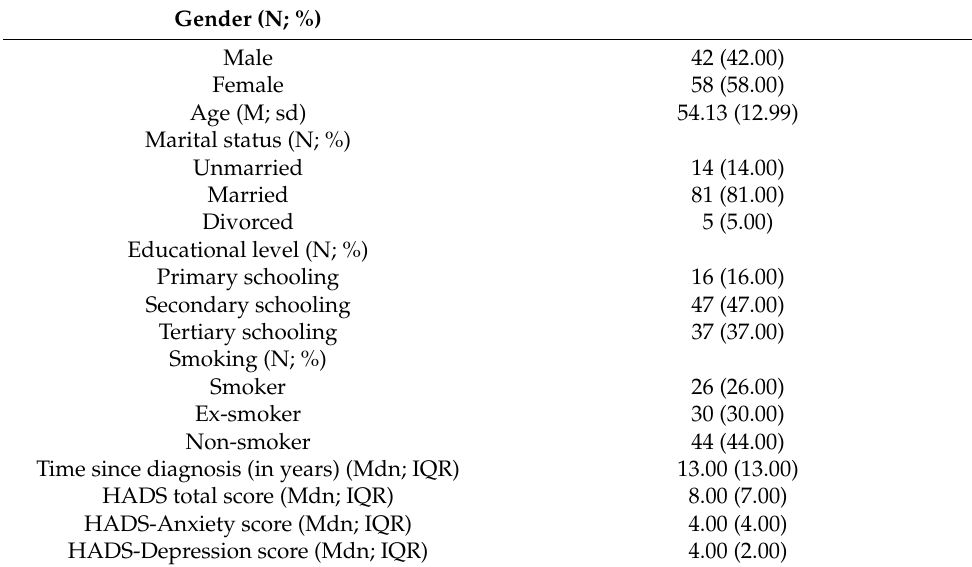
Table 1. The sample’s socio-demographic and clinical